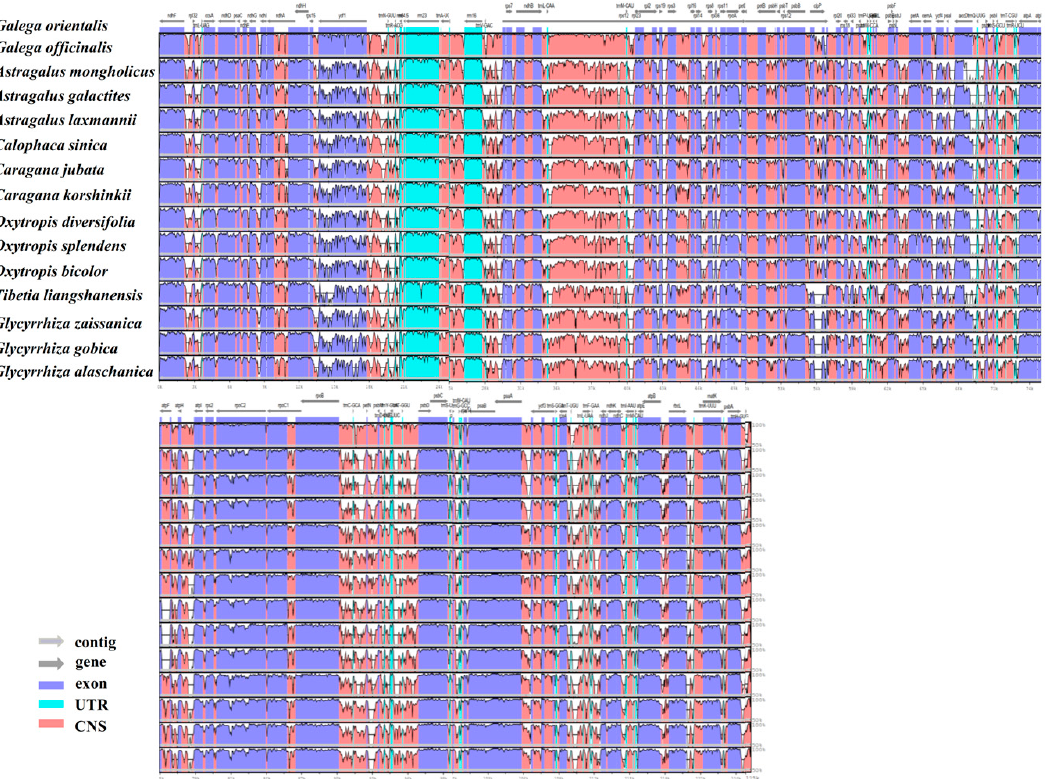
Figure 6. The comparison of 15 Galegeae species cp genomes by using mVISTA. G. orientalis as a reference, genomic regions are color-coded to indicate protein-coding regions, exons, UTRs, and CNS.